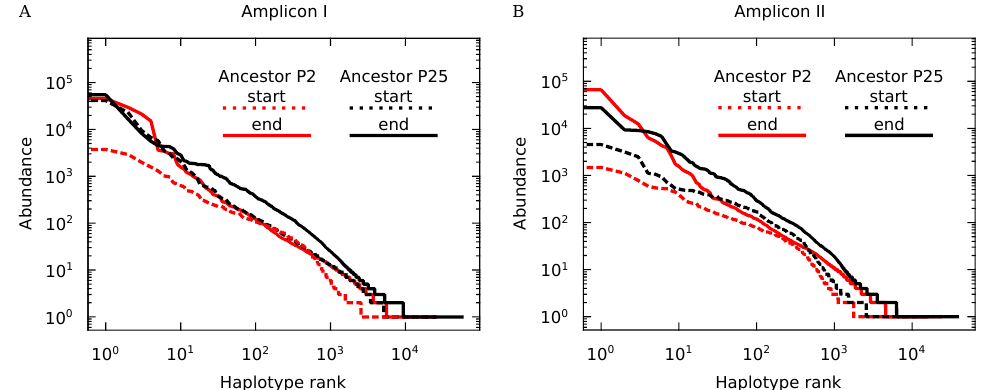
Figure 4. Rank ordering of haplotype abundance for ancestral and evolved populations in the regions corresponding to ( A ) amplicon I and ( B ) amplicon II. See the main text for a discussion.